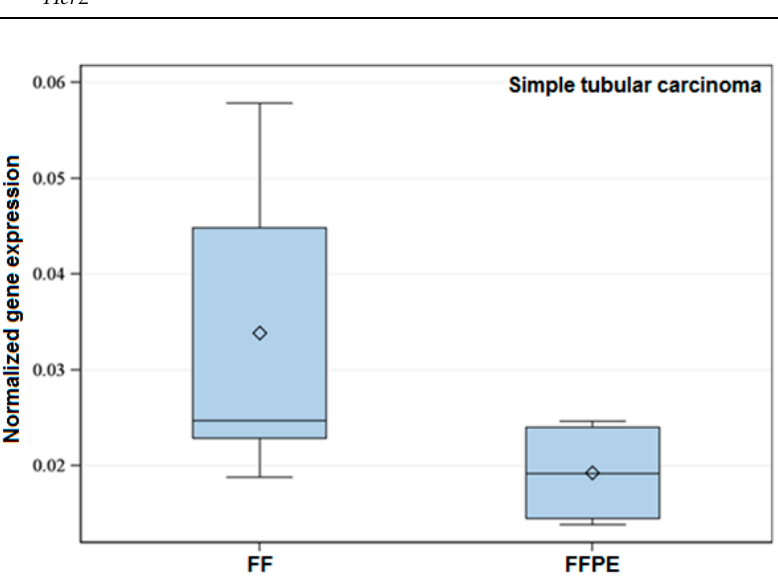
Figure 1. Exemplary box-plot figure showing the normalized expression of Tp53 within the histological Group 6 (Simple tubular carcinoma). The normalized gene expression of the referred gene is lower in FFPE when compared to FF specimens. Data showed significant difference ( p < 0.05).